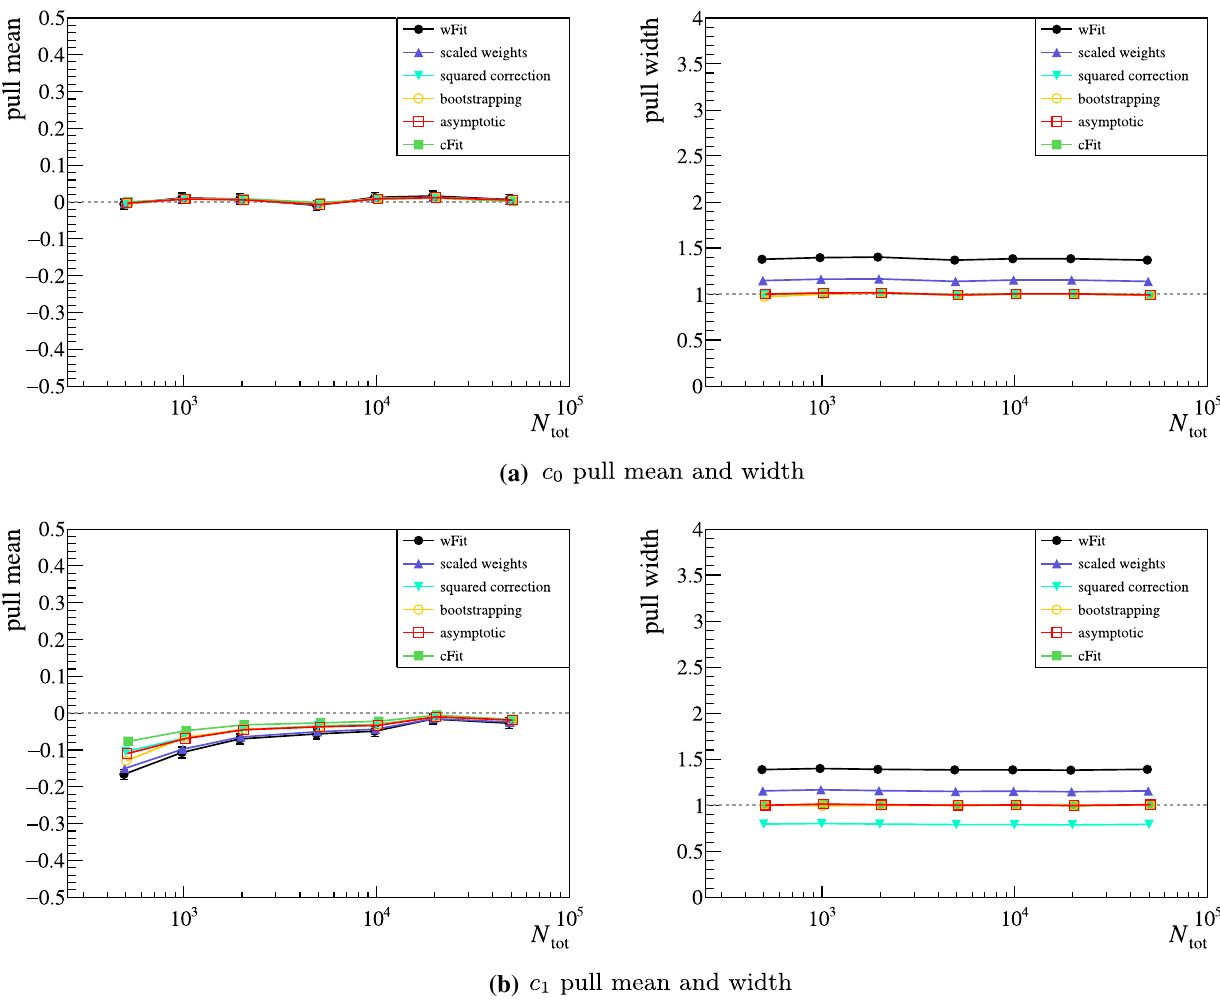
Fig. 4 (Left) Pull means and (right) pull widths for the efficiency correction (cid:4)( cos θ) = 1 . 0 − 0 . 7cos 2 θ , depending on total event yield N tot . The markers are slightly horizontally staggered to improve readability